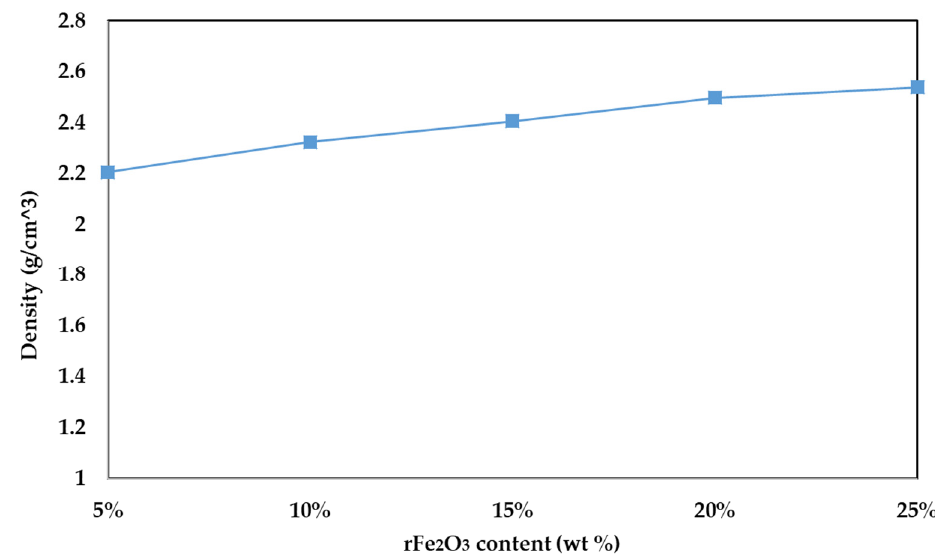
Figure 10. Density vs. various rFe 2 O 3 nanofiller content for rFe 2 O 3 –PTFE